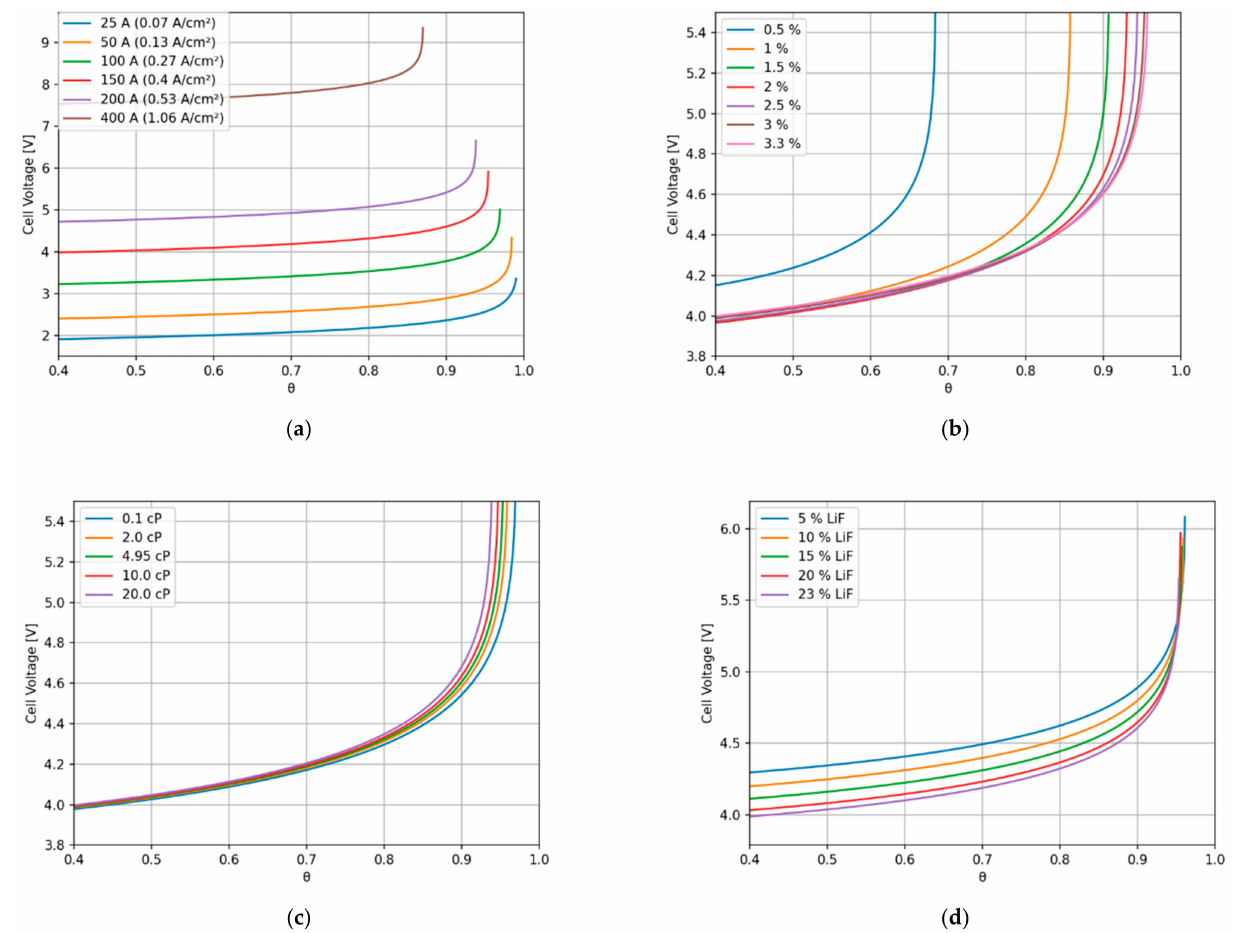
Figure 7. Overall cell potential for different: ( a ) current densities; ( b ) oxide contents; ( c ), viscosities; ( d ) electrolyte